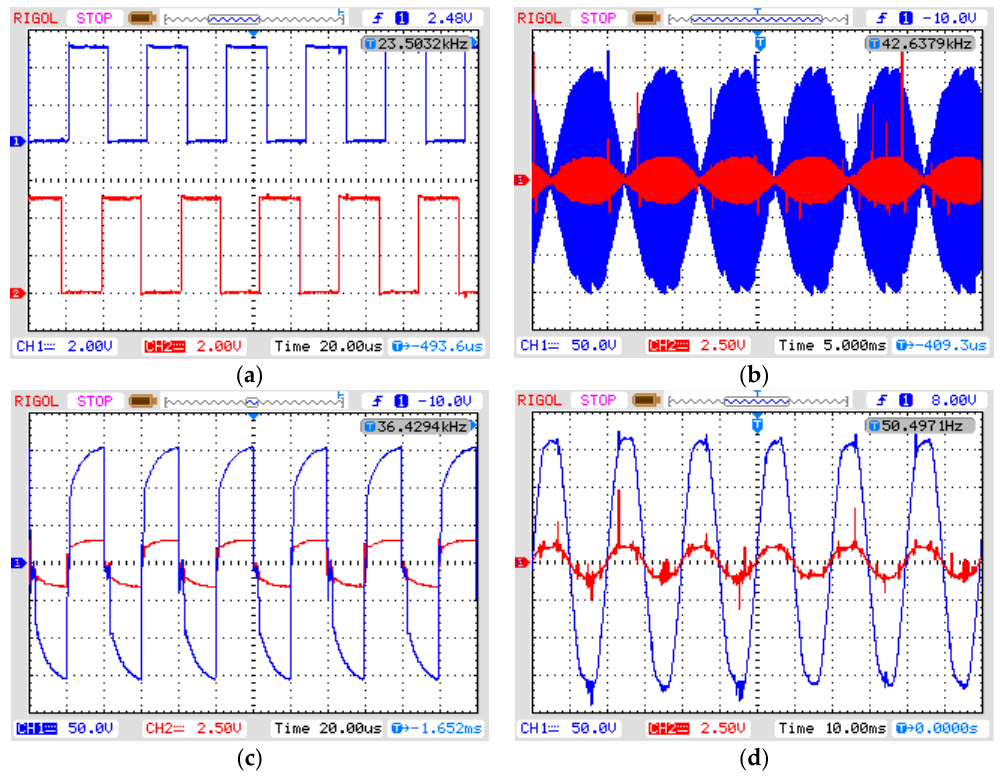
Figure 12. Outputs with 25 kHz switching frequency: ( a ) switching signals; ( b ) output voltage-current waveforms; ( c ) output voltage-current waveforms in zoom form; ( d ) input voltage-current